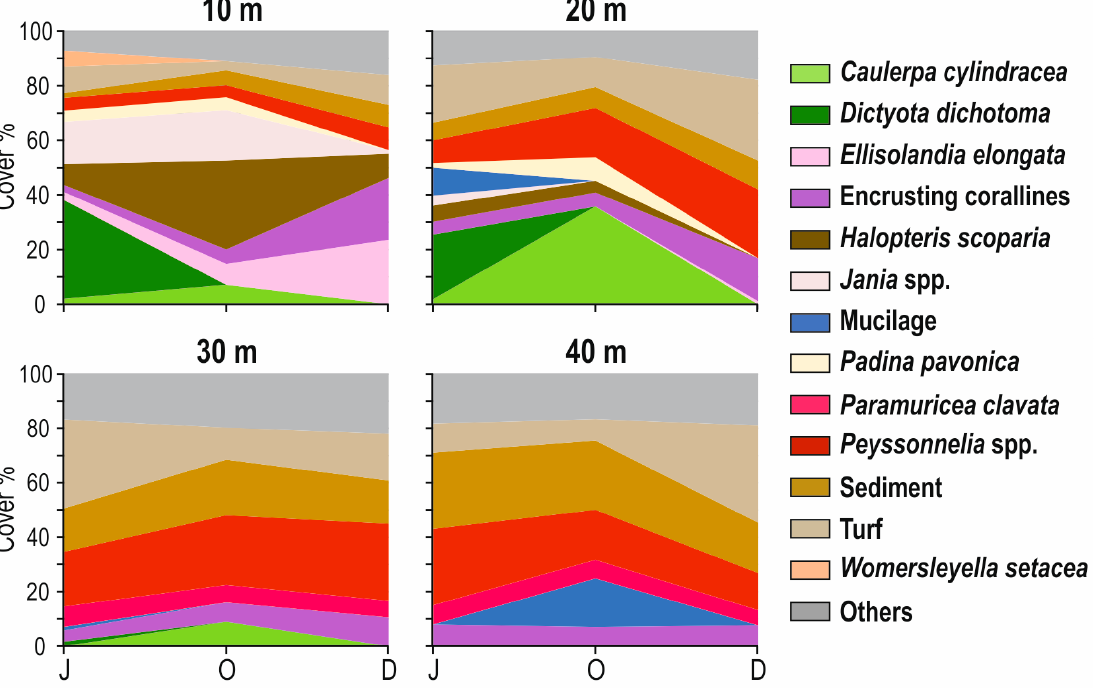
Figure 5. Compositional change in the rocky reef communities of Portofino MPA at the three times investigated (J = June; O = October; D = December). The descriptor ‘others’ includes species whose cover was always <5%.